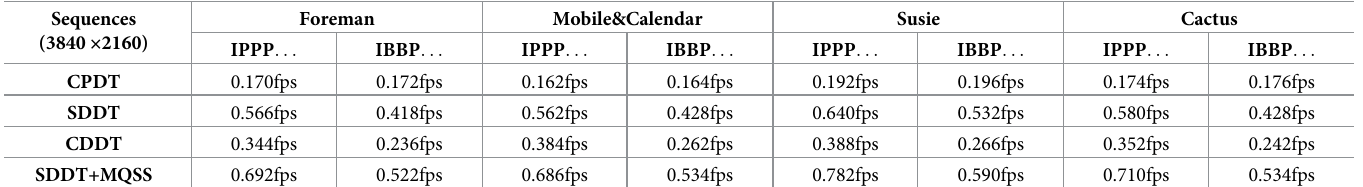
Table 4. The comparison of the proposed MQSS scheme using SDDT with CPDT, SDDT, CDDT, in terms of fps, for the Foreman , Mobil & Calendar , susie and Cac- tus 4-k ultra-HD sequences which are encoded at QP = 7, and then transcoded at QP = 15. Sequences (3840 ×